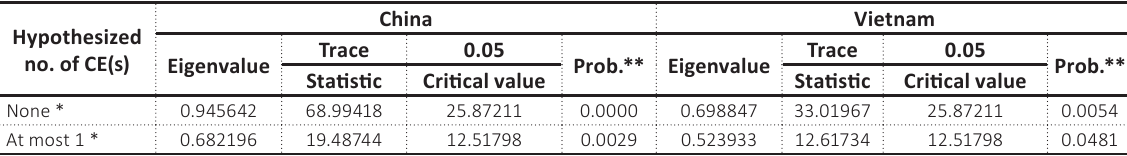
Note: * MacKinnon (1996) one-sided p-values. Table 6. Test result for cointegration of inflation and lending rates in China Hypothesized no. of CE(s)